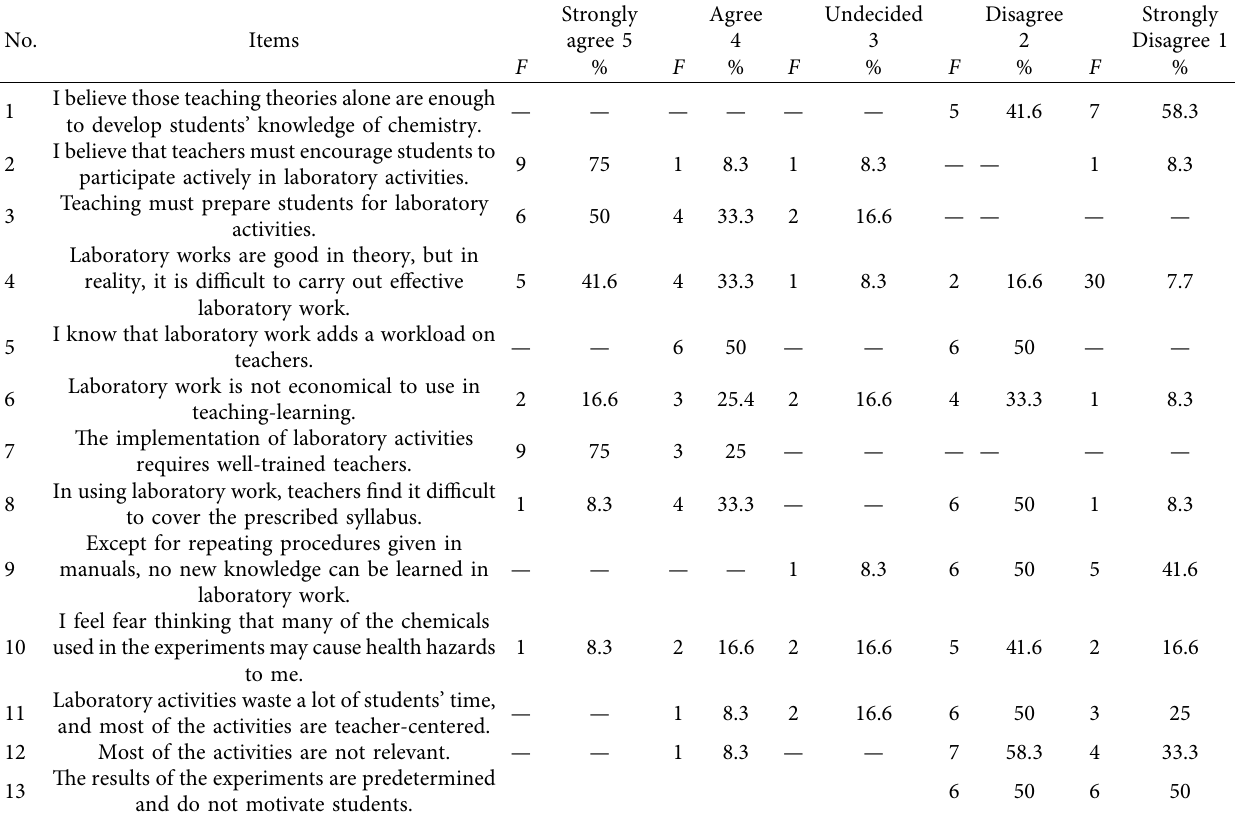
Table 2: Teachers’ response on their perception of laboratory work.